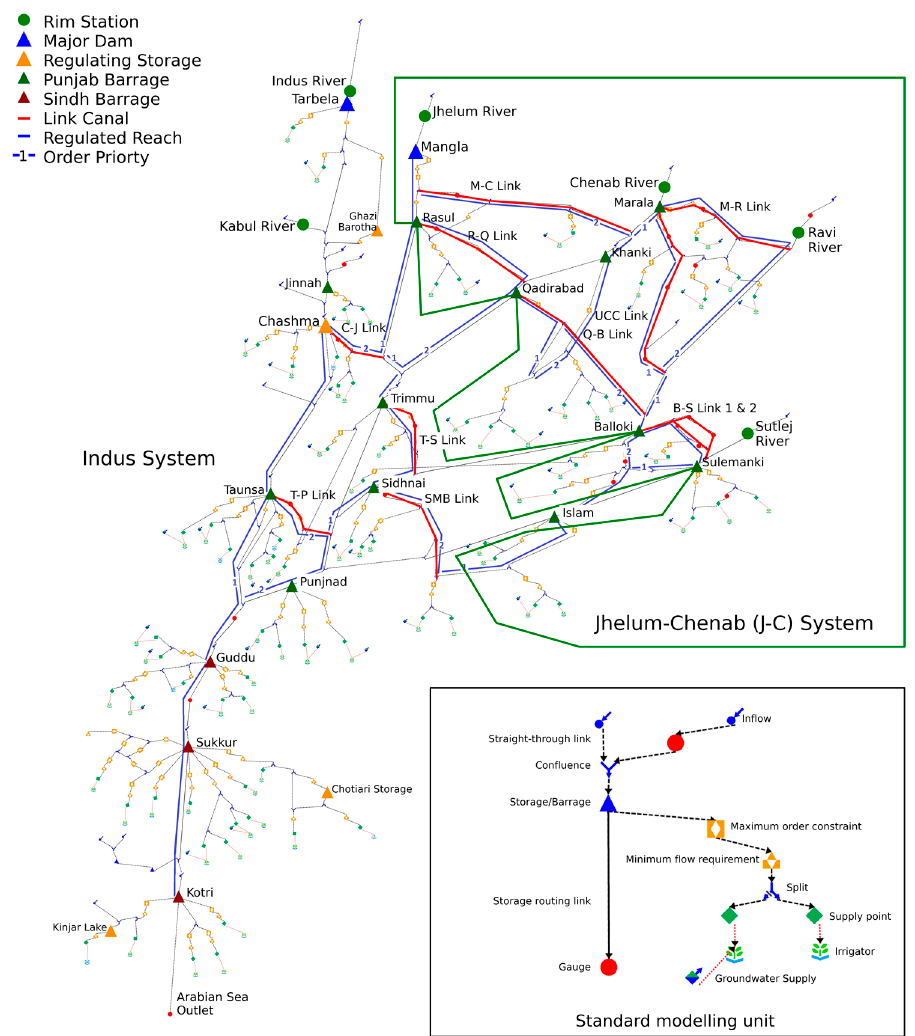
Figure 4. Indus River System Model (IRSM) schematic as implemented in the eWater Source, showing water ordering priority pathways in IBIS. Inset: standard modelling nodes and typical layout.